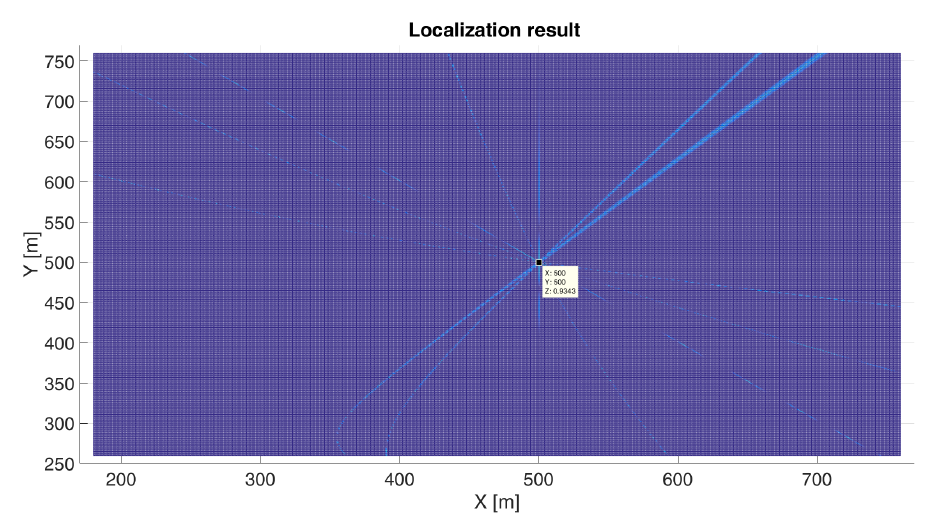
Figure 6. The localization results of one acoustic source in 2D